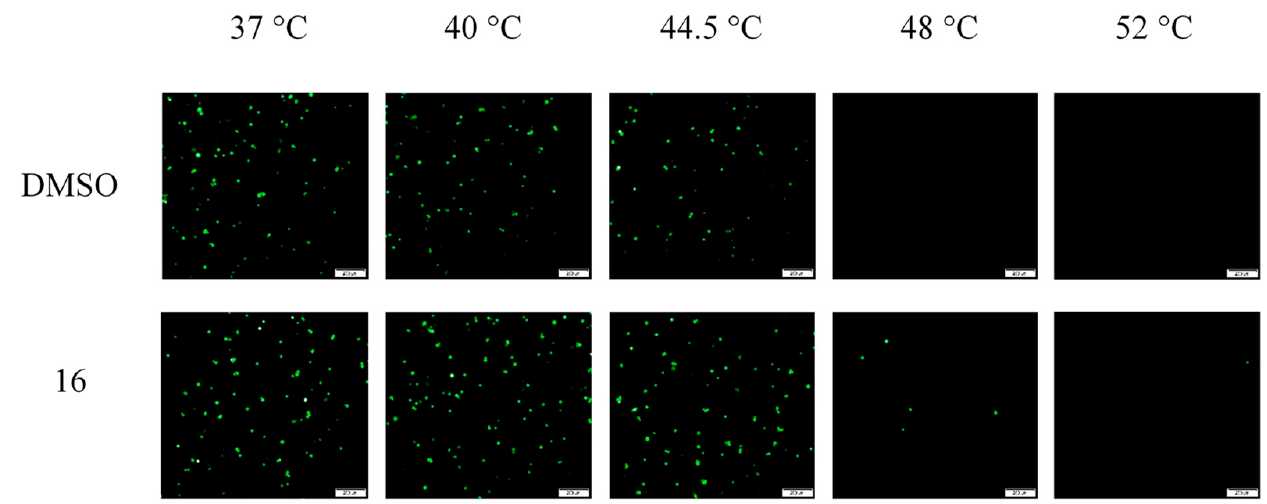
Table 3. Two out of three double combinations showed a synergistic effect, and concretely, the combination of compounds 4 and 16 (ratio 1:4.3) showed strong synergism (ED 50 = 0.26) and the combination of compounds 6 and 16 (ratio 1:1.73) was also classified as synergistic (ED 50 = 0.40), while the combination of compounds 5 and 16 (ratio 1:2.9) showed only an additive effect (ED 50 = 1.09). For the triple combinations, one of them (the combination of compounds 4 , 5 , and 16 ; ratio 1:1.5:4.3) exhibited a synergistic effect with an ED 50 value of 0.33, while the other triple combination (compounds 5 , 6 , and 16 ; ratio 1:1.7:2.9) showed a clear antagonistic effect (ED 50 = 2.01), probably due to compound interactions. It is worth noting that in our previous report, the combinatory index also increased when compound 5 was added to the mix, reaching additive or antagonistic values.